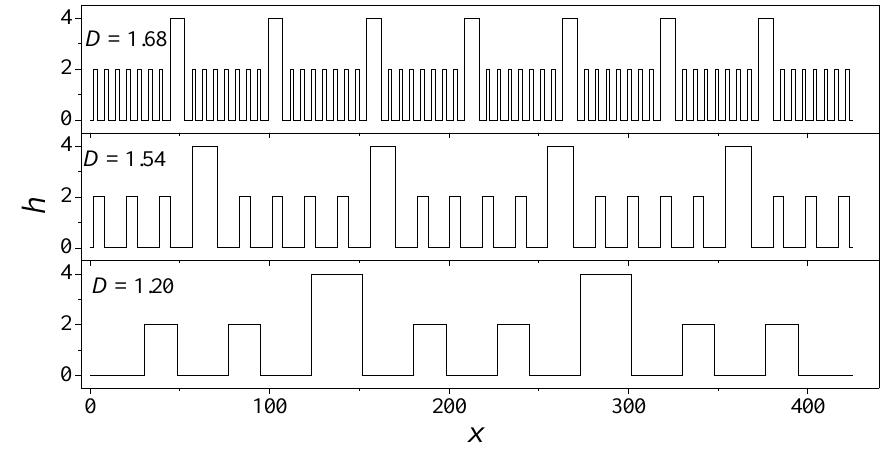
Figure 1. Fractal description of rough surface with different fractal dimensions.